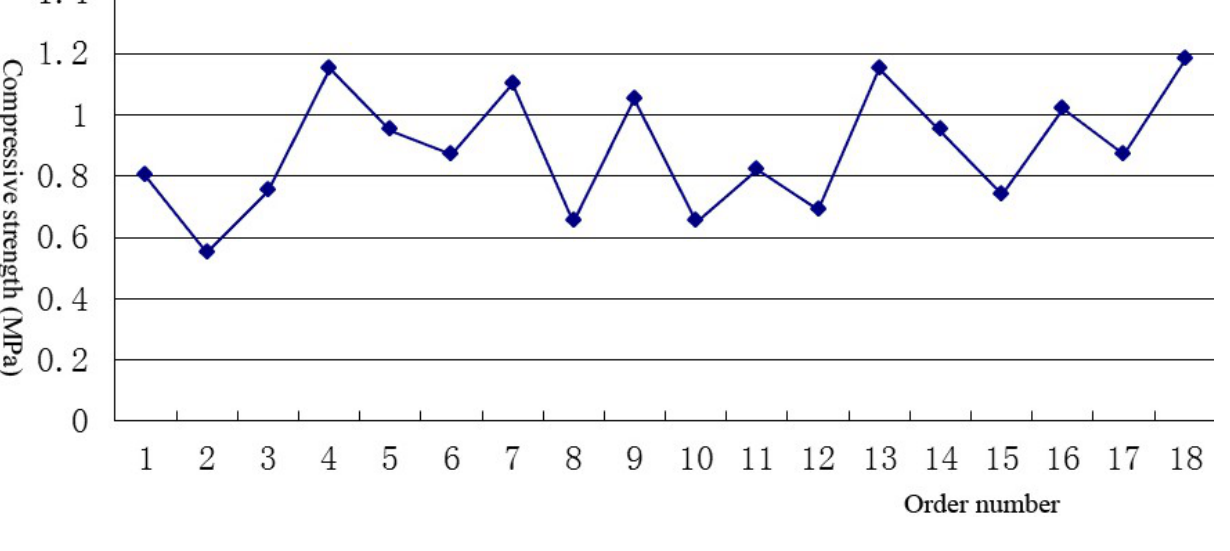
Figure 4. Compressive strength test results for a hardened layer of an antifouling structure.